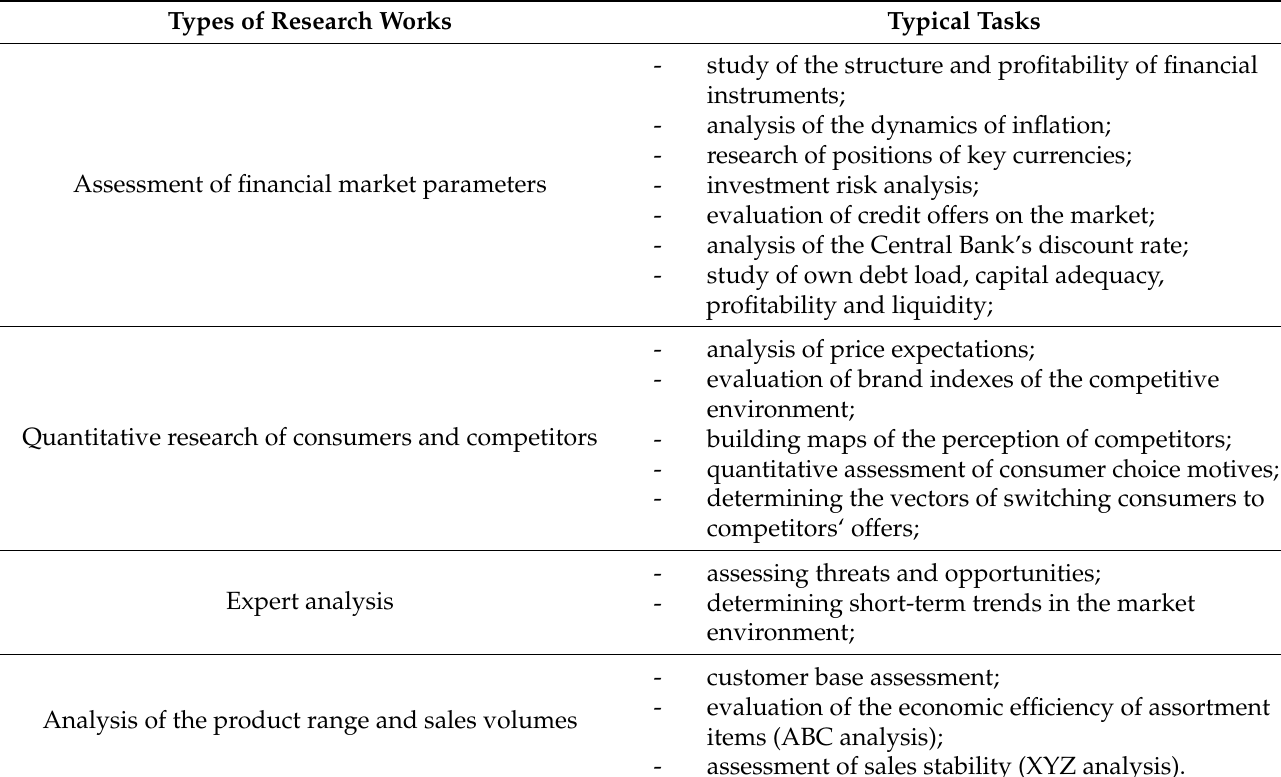
Table 2. Indicative list of research works in the process of assessing the state and degree of influence of the business environment on the implementation of the financial strategy of the Russian energy holding. Types of Research